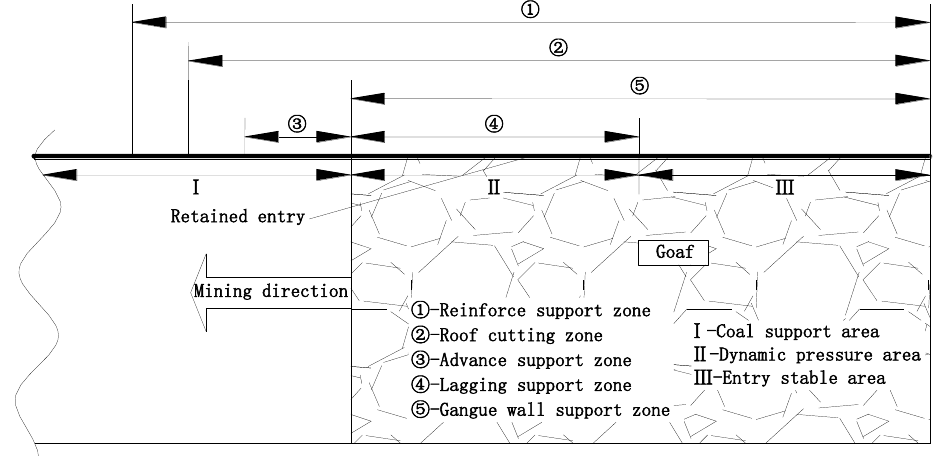
Figure 16. Process zoning map of GERRC in the 8304 longwall working face retained Figure 16 . Process zoning map of GERRC in the 8304 longwall working face retained entry .